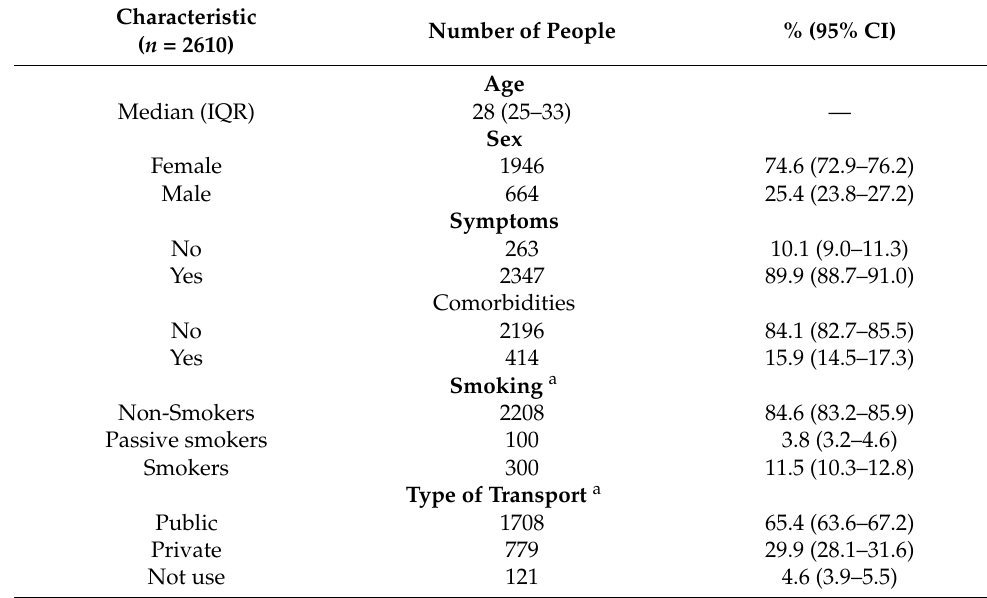
Table 2. Sociodemographic characteristics of HCWs with COVID-19.